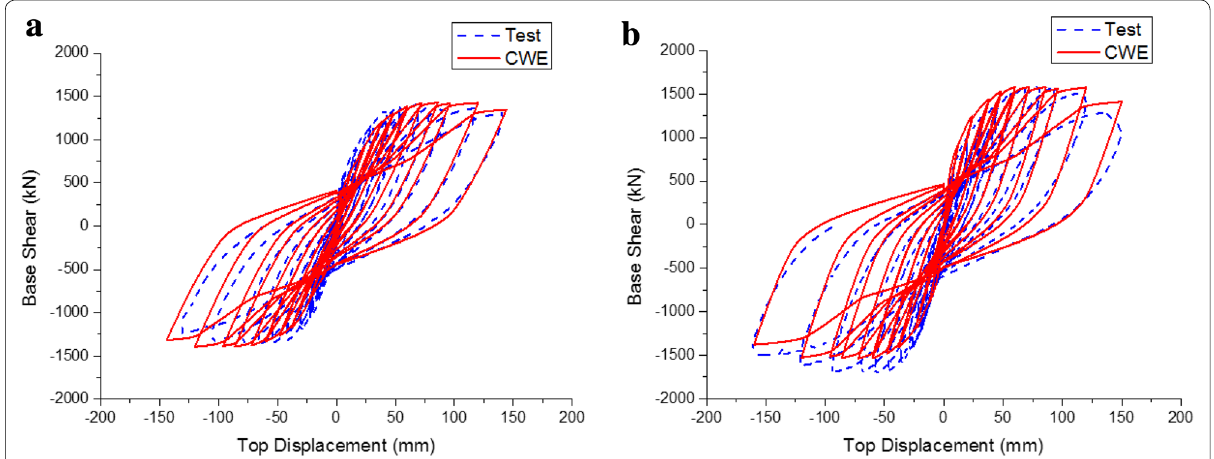
Fig. 14 Comparisons between the experimental data and the analytical results using the proposed CWE models: a CW-1 and b